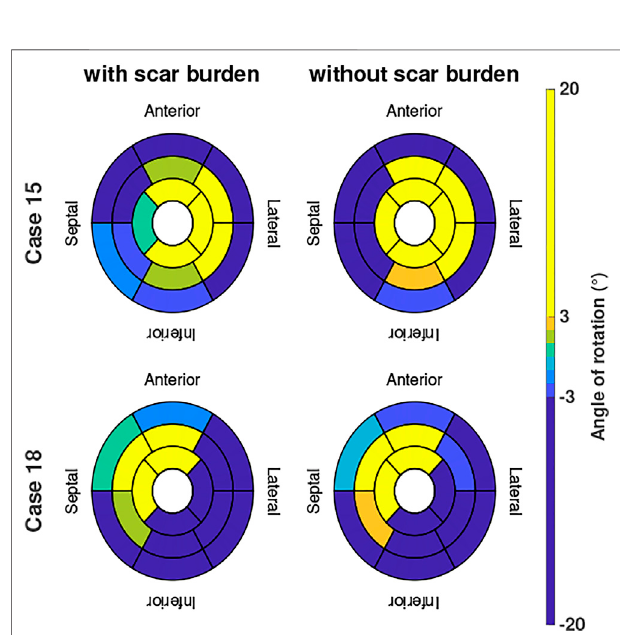
FIGURE 6 | Angle of rotation for Cases 15 and 18 shown in bullseye perspective for simulations with and without local scar burden.